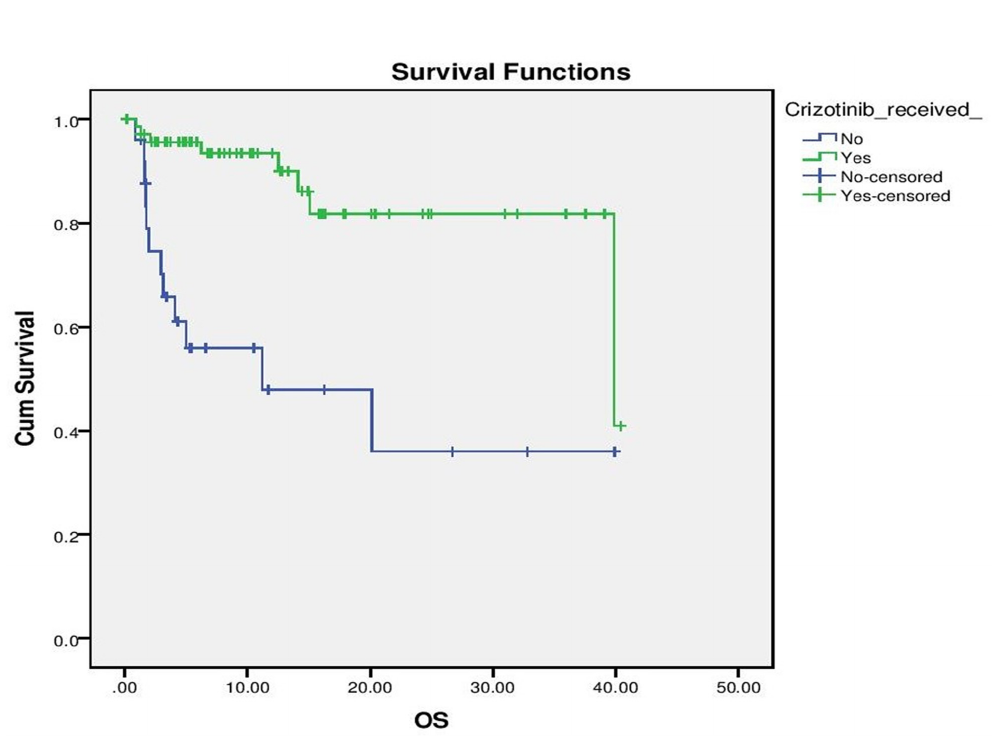
Fig 6. Overall Survival as per Performance Status.